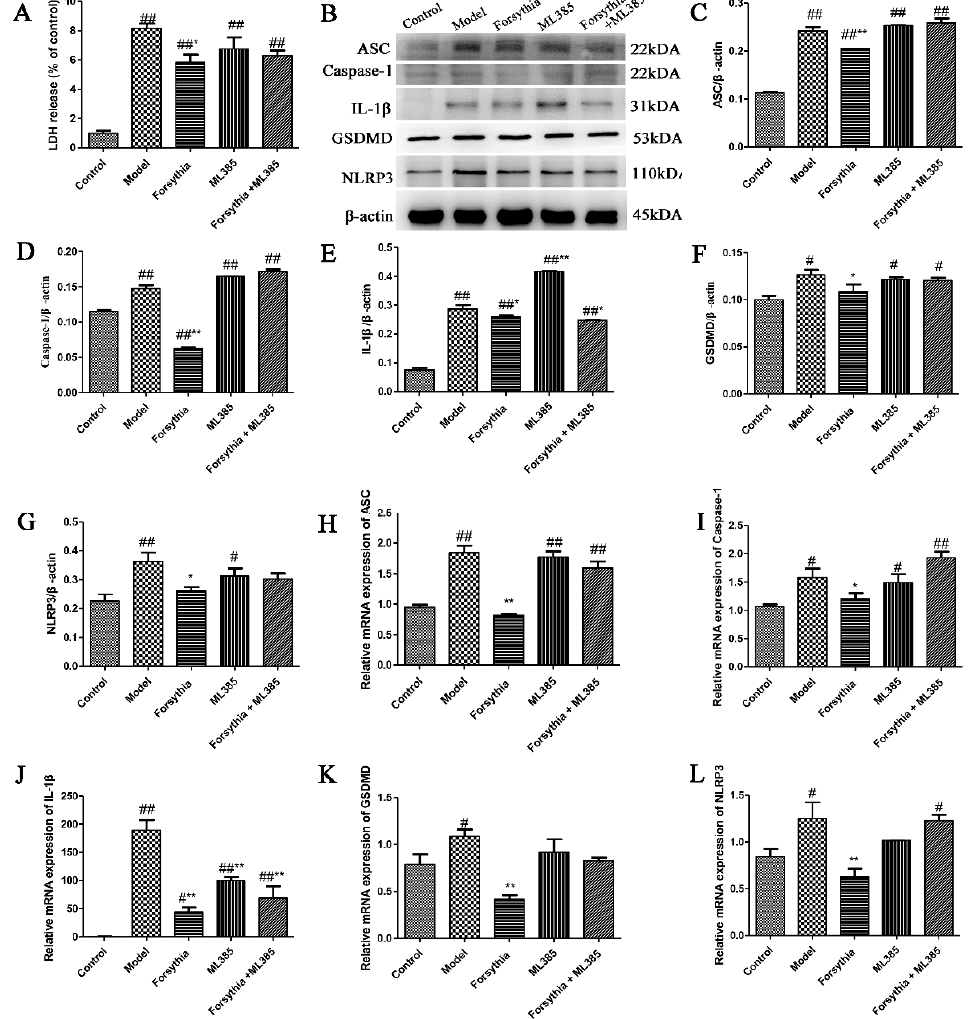
Figure 10. The effect of Forsythia suspensa extract in inhibiting pyroptosis may be related to its antioxidant effect. ( A ) LDH levels in J774A.1 cells. ( B – G ) Western blot analysis of ASC, Caspase-1, IL-1 β , GSDMD and NLRP3. ( H – L ) qRT–PCR detection of ASC , Caspase-1 , IL-1 β , GSDMD and NLRP3 gene expression levels. Data represent at least three independent experiments. The results are shown as the mean ± SEM. # p < 0.05, and ## p < 0.01 compared with the control group; * p < 0.05, and ** p < 0.01 compared with the model group; ##* means ## and *; ##** means ## and **.